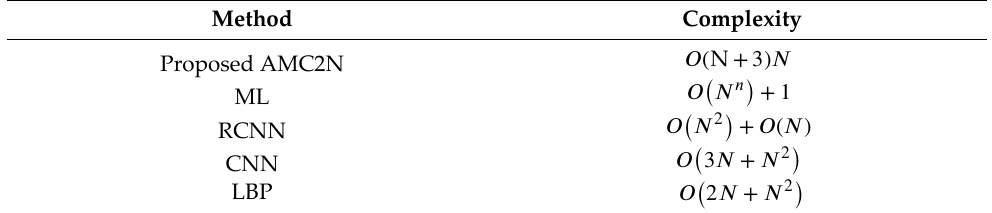
Table 8. Complexity